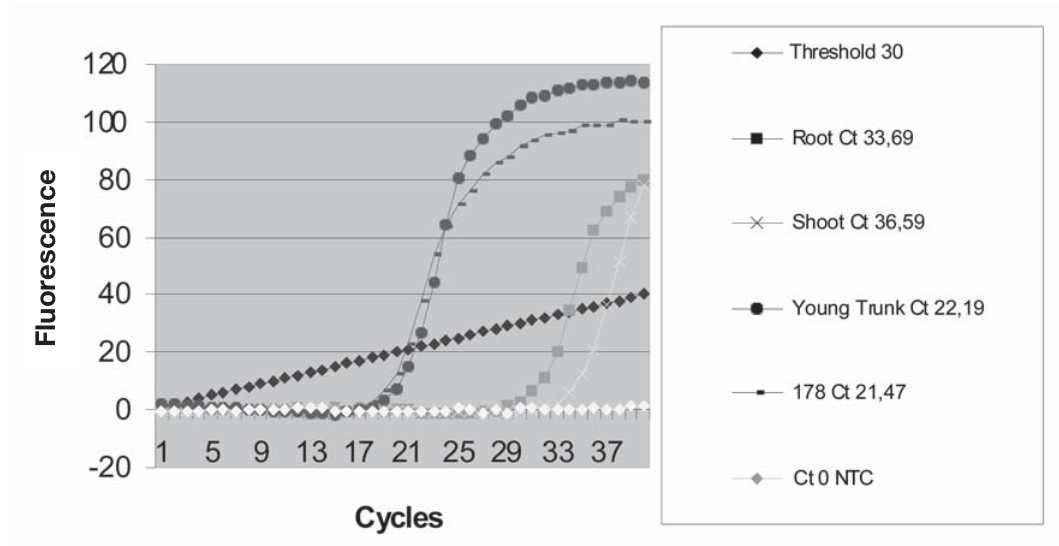
control.Fig. 4. Real-time PCR data from 1 of 3 replicates for plants drill-inoculated with Phaeomoniella chlamydospora . Cycle threshold (Ct) scores were recorded when fluorescence values crossed an original threshold set at 30 florescence